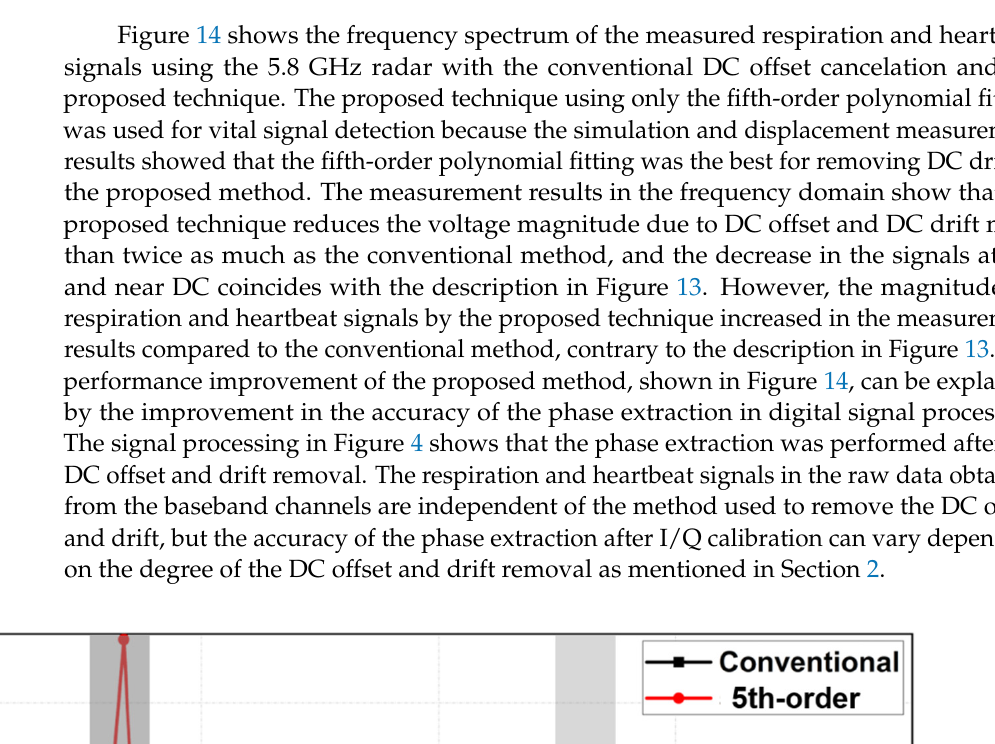
Figure 13. DC drift in the respiration and heartbeat detection using the CW radar.